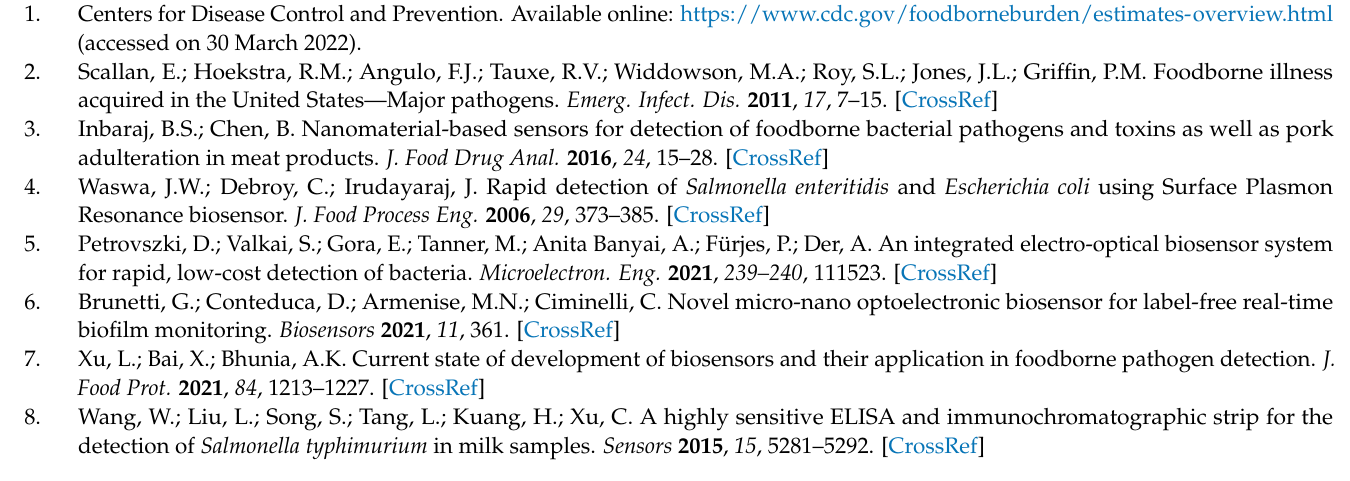
Figure S2: Optimization of LPS concentration used for coating; Figure S3: Optimization of anti- bacteria specific antibody concentration; Figure S4: Optimization of flow rate; Figure S5: Real-time responses from a chip spotted with the LPS of E. coli and S. typhimurium ; Table S1: Results of recovery experiment; Figure S6: Regeneration of the